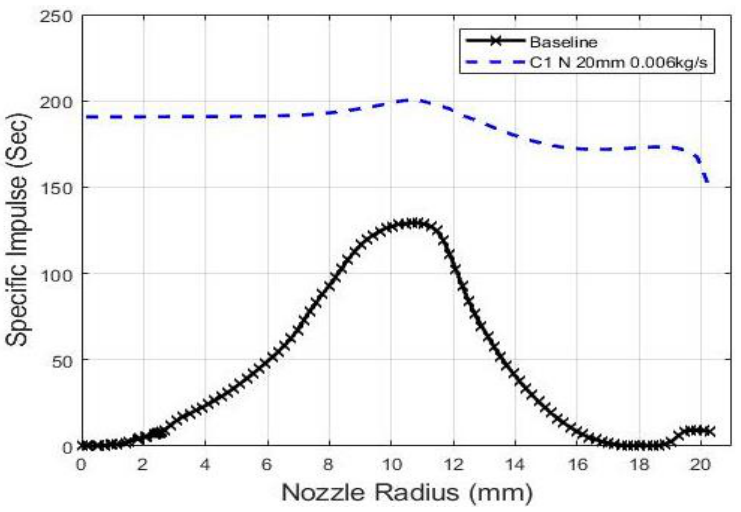
Figure 27. Isp vs. nozzle